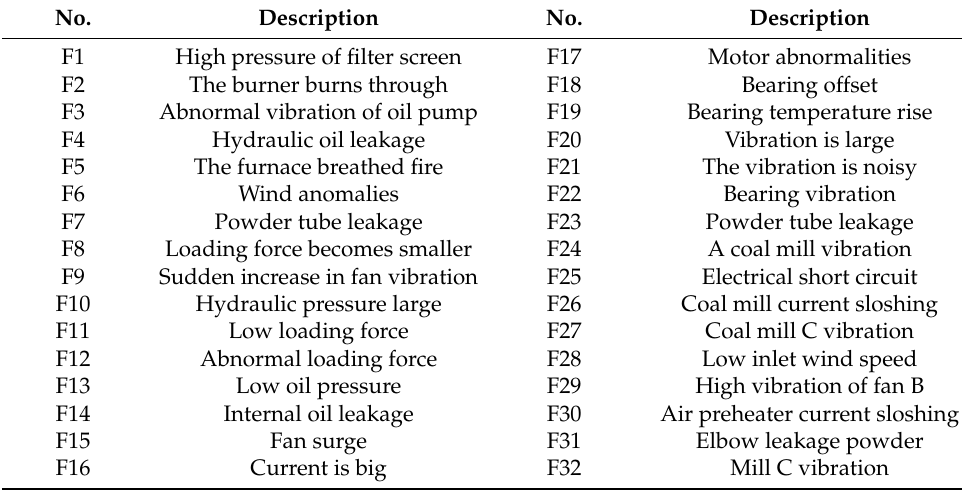
Figure 5. Physical photo of coal mill in power plant. Table 3. The main performance parameters of the coal